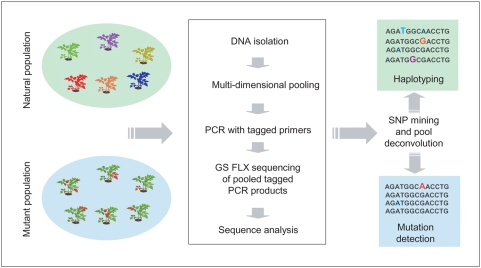
KeyPoint flowchart.